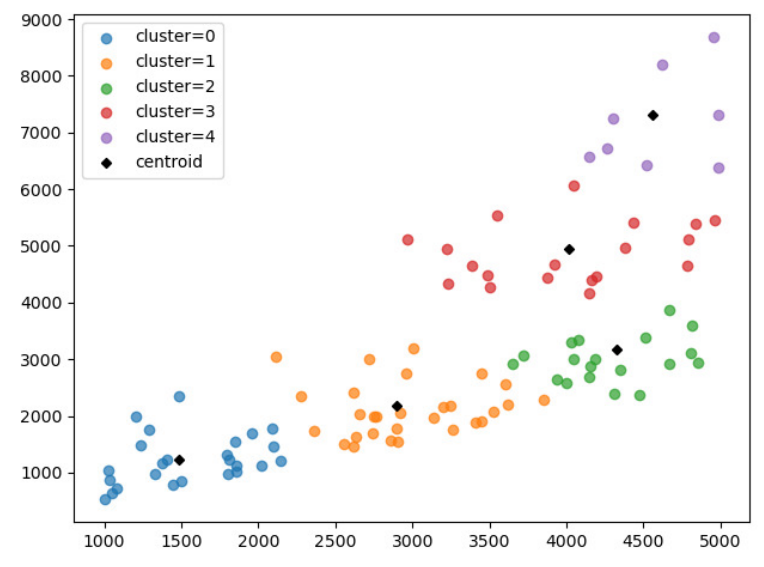
Figure 4. Tourist clustering